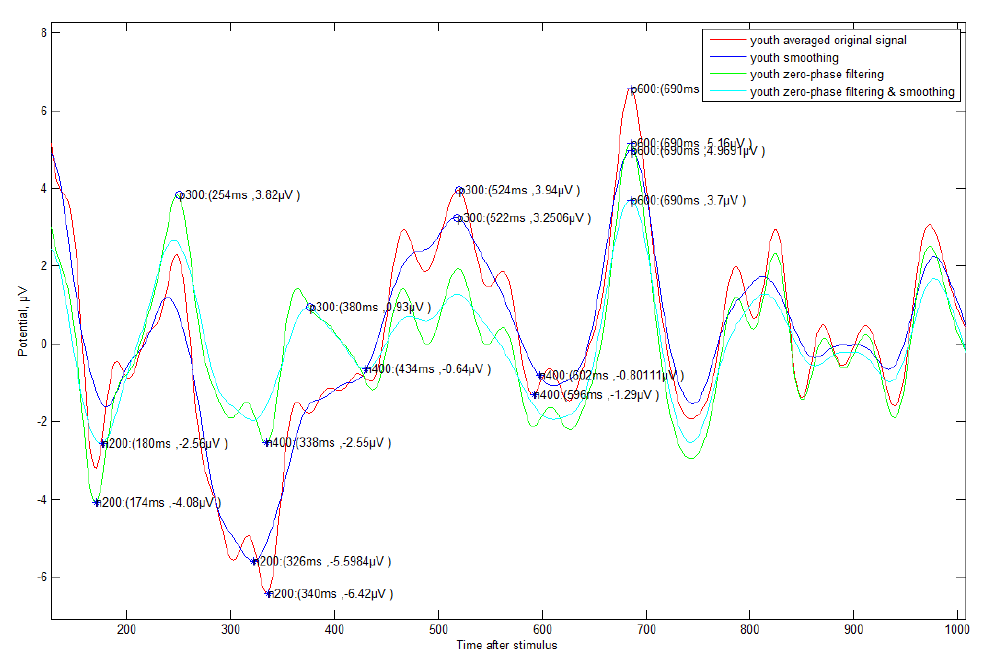
Figure 10. ERP Case Study 4—Young subject (#1)’s incorrect answer about triangle symbol: It is weaker than the elderly, but fluctuation is also more severe compared to the correct